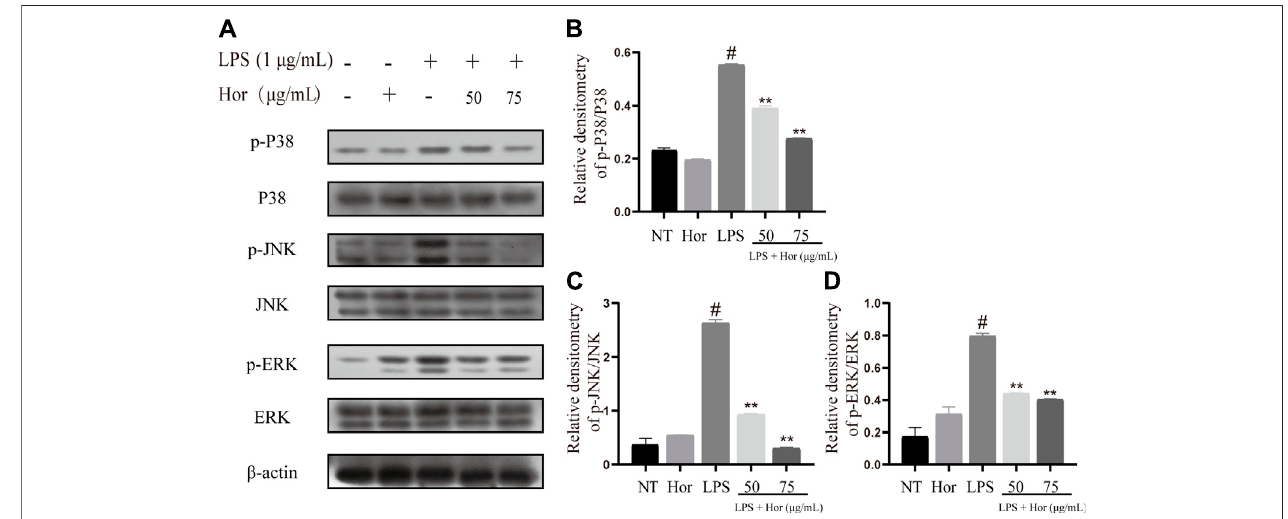
FIGURE 7 | Hordenine inhibits activation of the MAPK signaling pathway in LPS-induced RAW264.7 cells. (A) Expression of p-p38, p38, p-JNK, JNK, p-ERK1/2, and ERK1/2 in RAW264.7 cells. (B – D) Relative density analysis of p-p38, p-JNK, and p-ERK1/2 protein bands in RAW264.7 cells; β -actin was used as an internal 2: phosphorylated extracellular signal-regulated kinase 1/2; p-JNK: phosphorylated c-Jun N-terminal kinase.